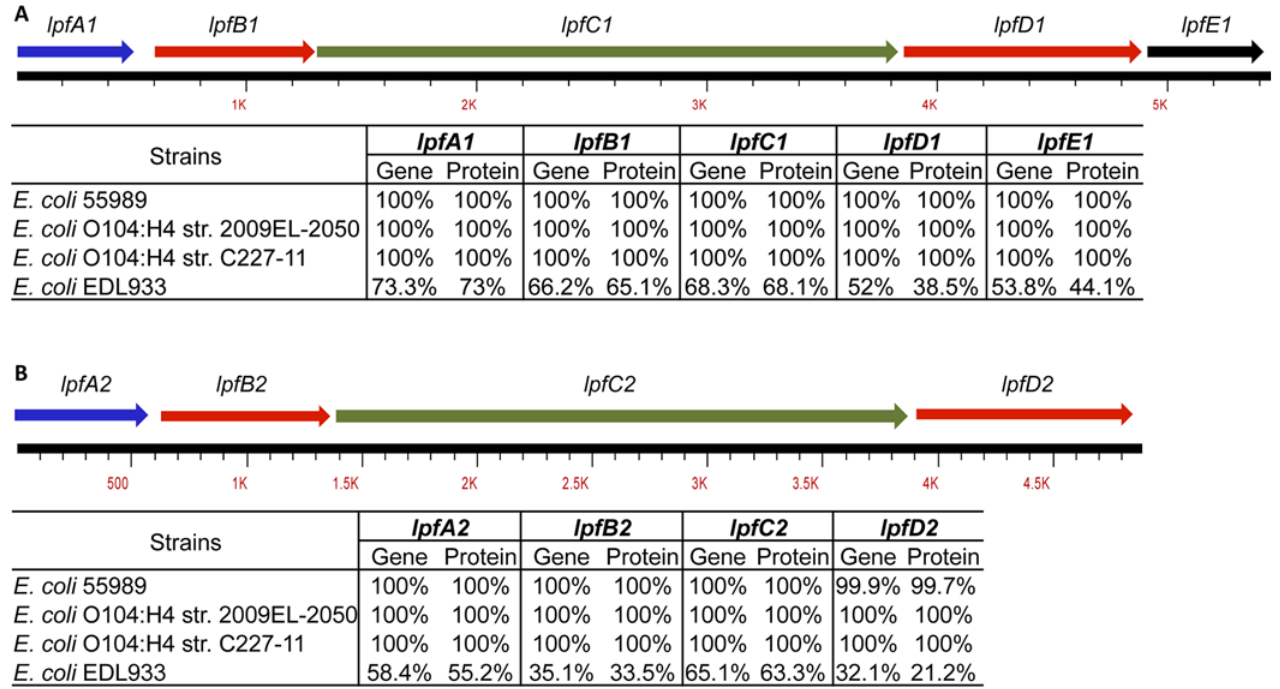
Fig 1. Conservation of lpf1 and lpf2 operons within E . coli O104:H4 and O157:H7. All genes and subsequent proteins from E . coli O104:H4 2011c-3493 where aligned with EAEC strain 55989, E . coli O104:H4 2009EL-2050 and O104:H4 C227-11. An alignment was also done with EHEC O157:H7 EDL933.